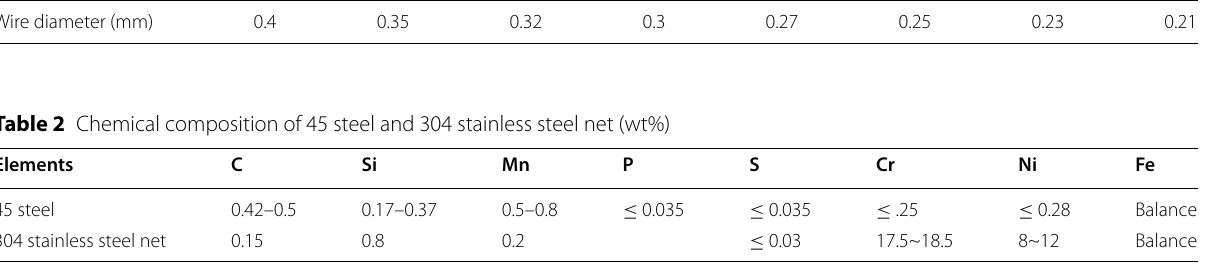
Table 1 The detail of 304 stainless steel Nets (mesh)